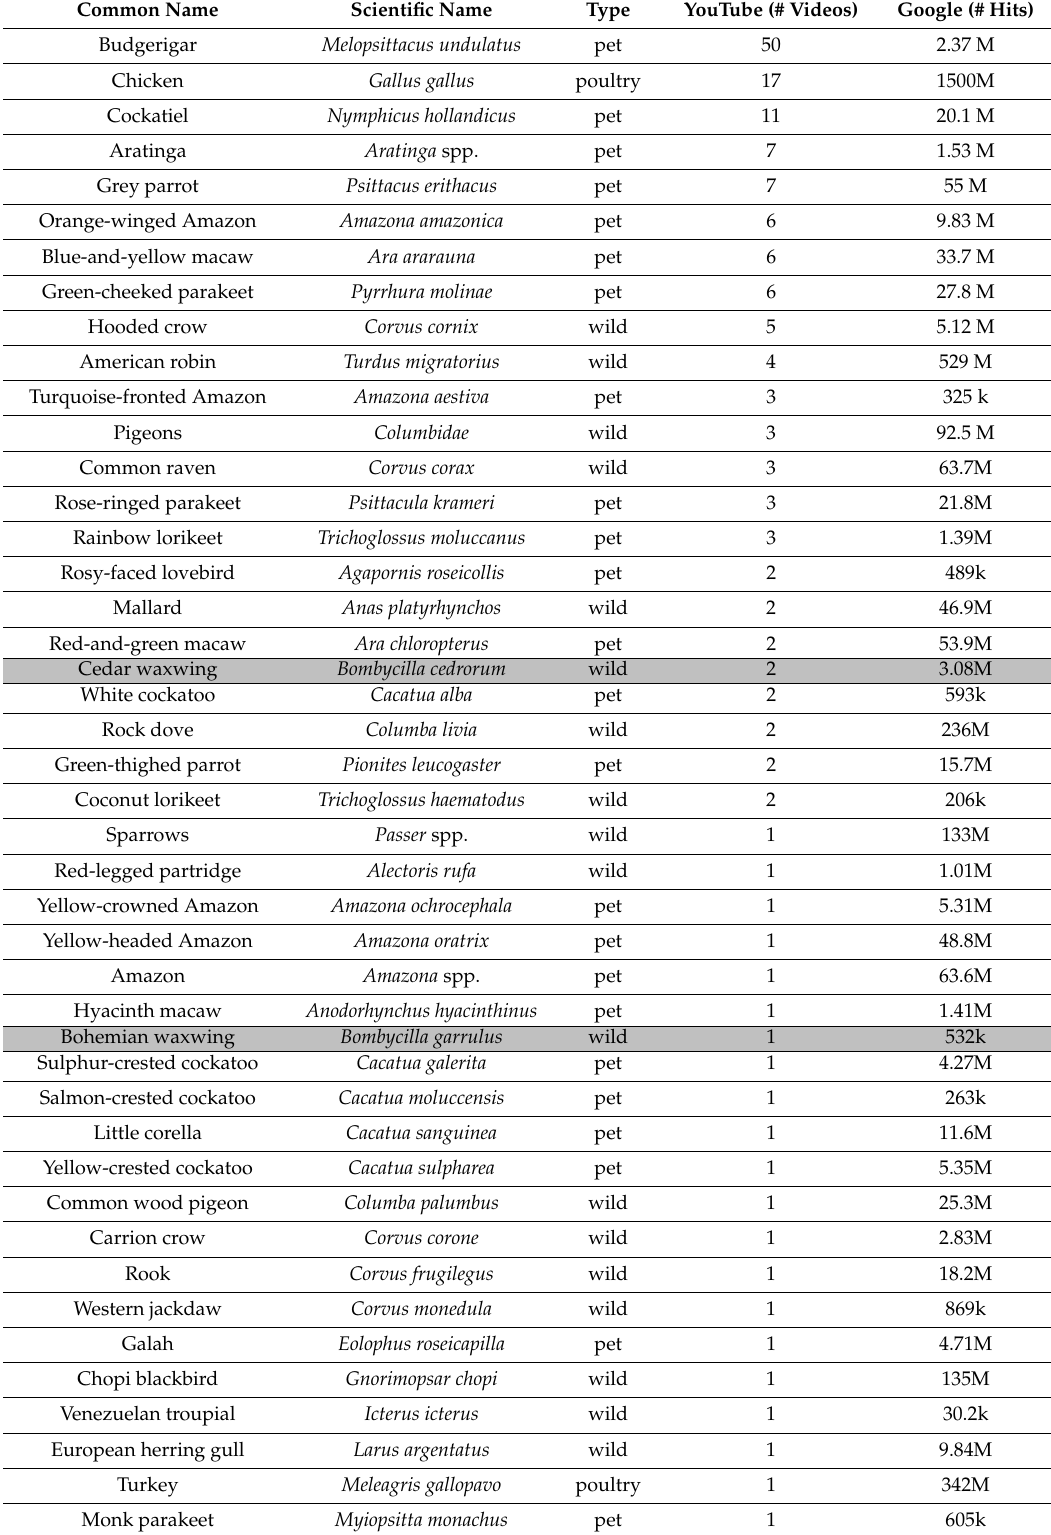
Table 2. List of bird species recorded in YouTube videos consuming alcoholic beverages. Birds are ordered according to the number of YouTube videos. Birds already mentioned in the scientific literature (Table 1) in the context of alcohol consumption are shaded grey. The type of bird (wild, pet or poultry) and the Google score (number of results (hits) given at the top of the first search page) are also